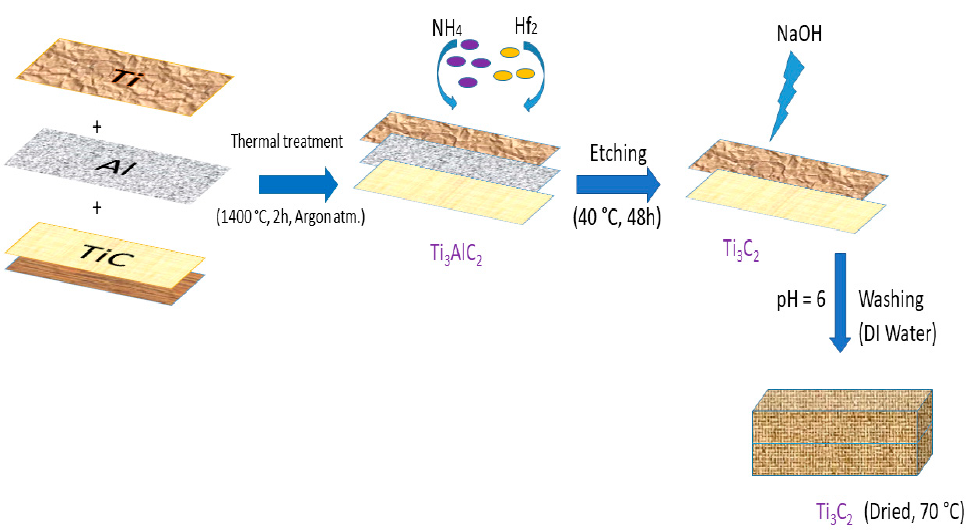
Figure 1. Schematics of MXene (Ti 3 C 2 ) synthesis from MAX phase (Ti 3 AlC 2 ).